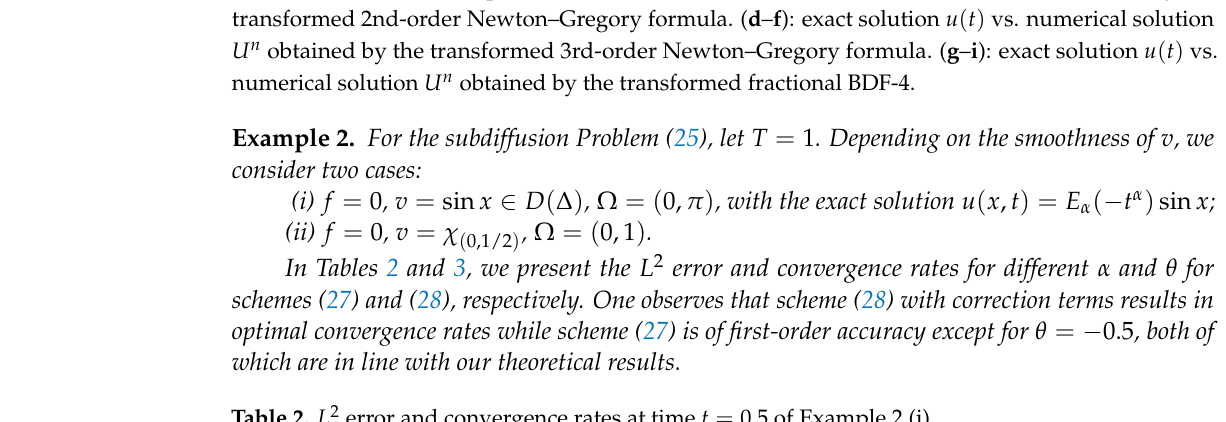
Table 2. L 2 error and convergence rates at time t = 0.5 of Example 2